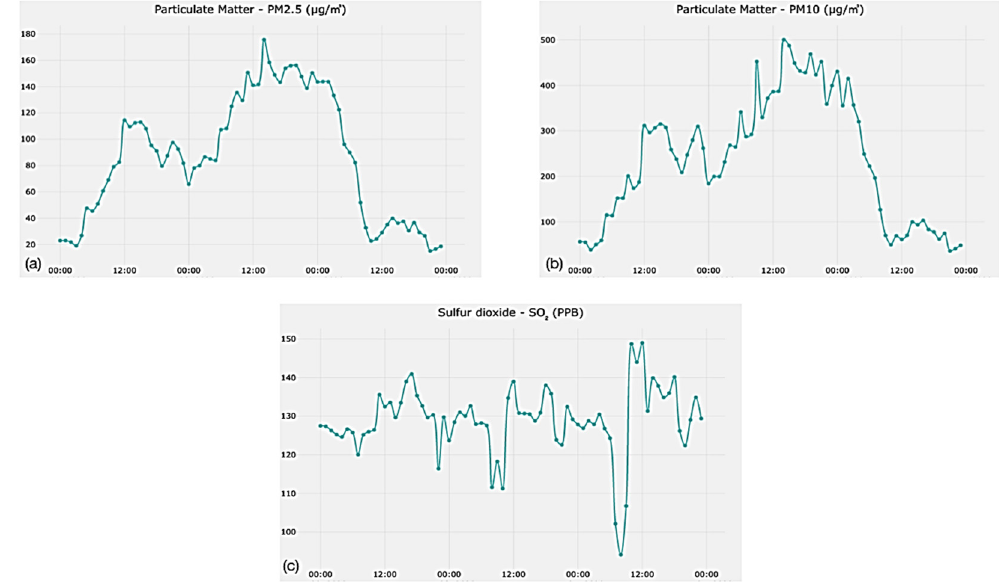
Figure 8. Hourly aggregated ( a ) fine particulate matter, ( b ) coarse particulate matter and ( c ) sulfur dioxide time series between 22 and 24 June 2020.